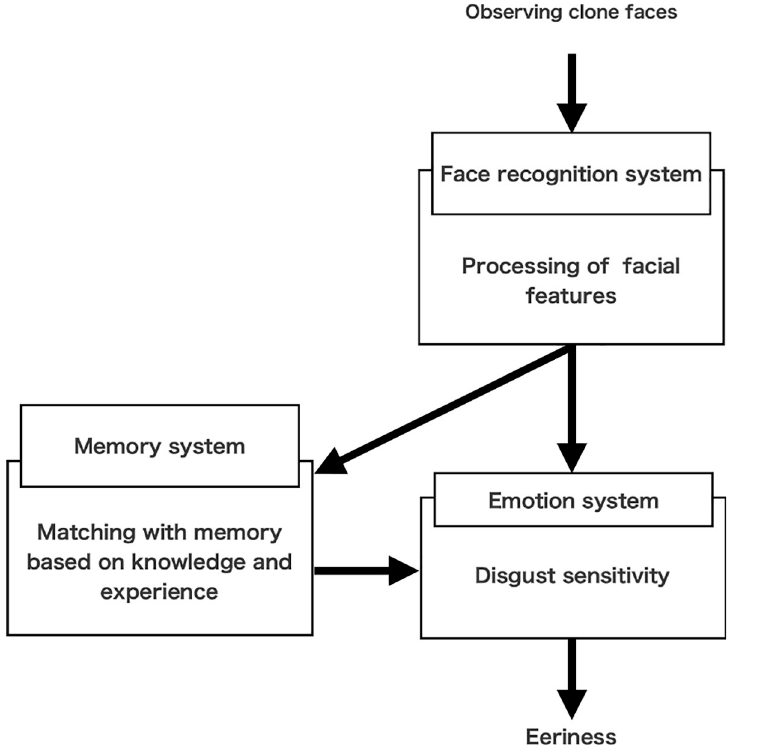
Fig 9. The mechanism of the clone devaluation effect proposed in the present